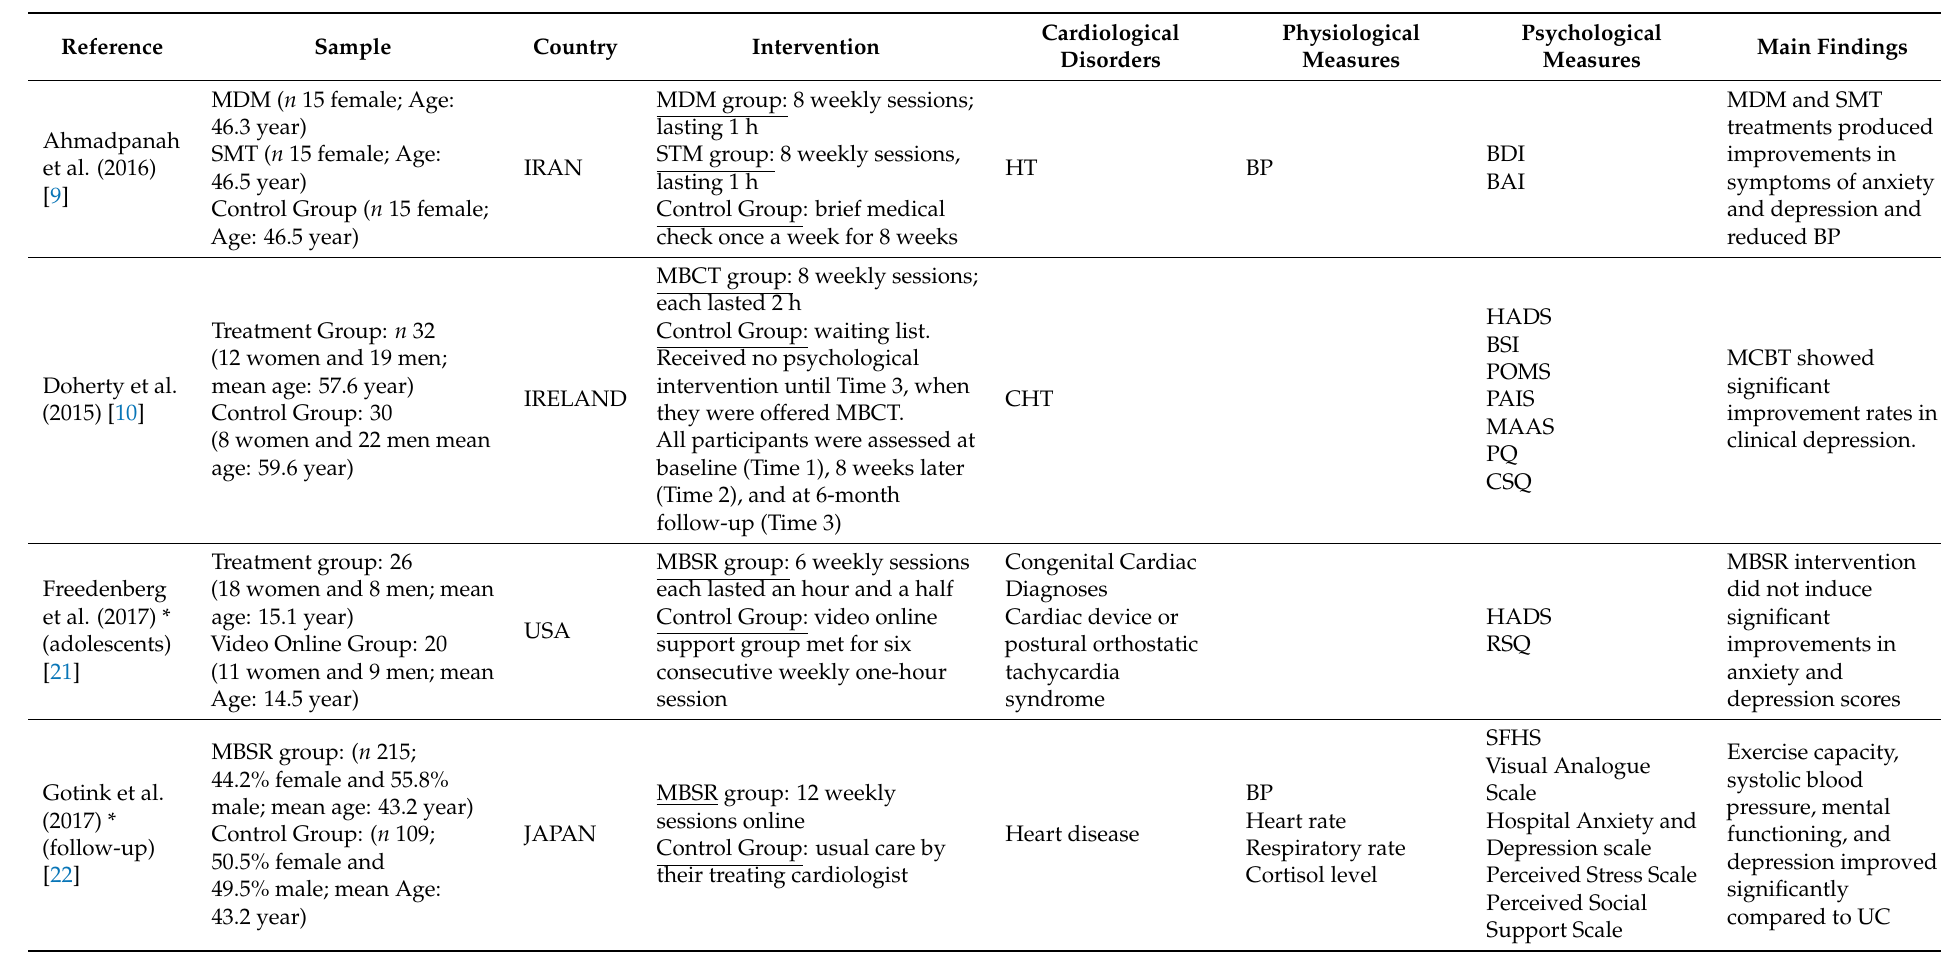
Table 2. Characteristics of studies assessing the effects of mindfulness on patients with cardiovascular